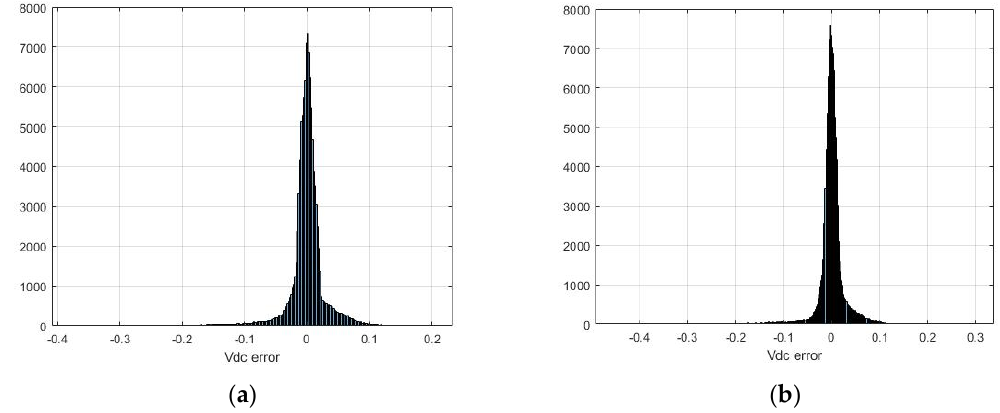
Figure A3. Error frequency distributions with ( a ) feed forward NN, and ( b ) cascade-forward NN.